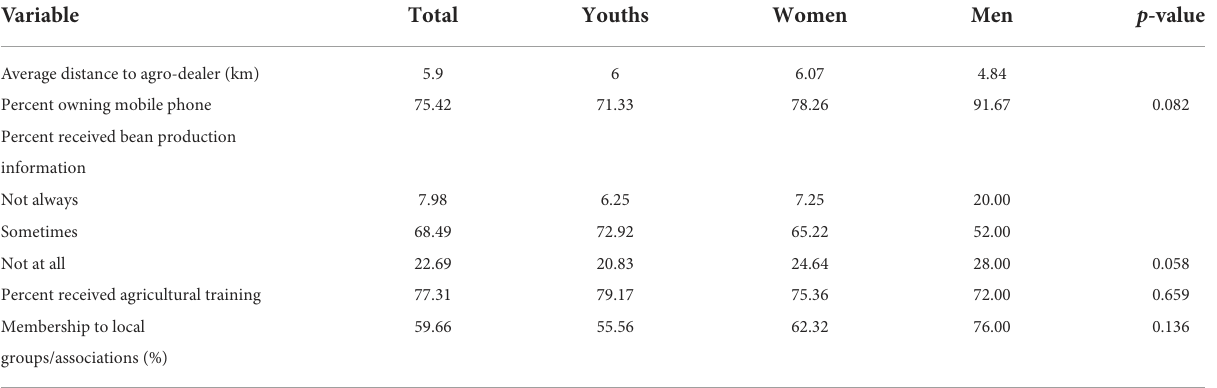
TABLE 6 Common bean farmers have access to institutional, technical, and social support services by gender. Variable